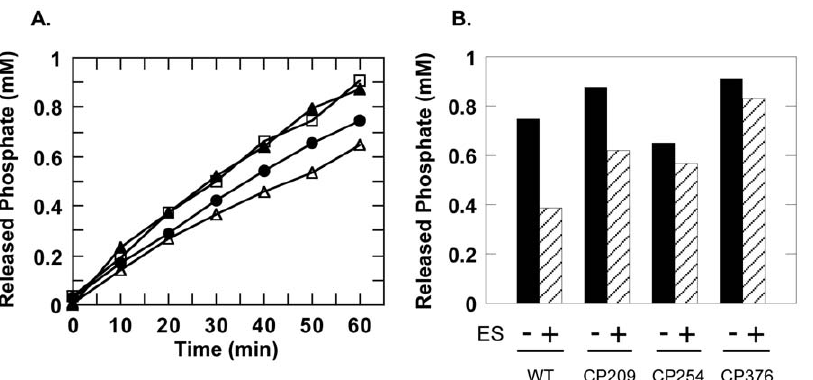
Figure 3. ATPase activities of wild type and CP GroELs. A. Basal ATPase activities measured at 25 u C. Closed circles indicate wild type GroEL, closed triangles indicate CP209. Open triangles indicate CP254 and open squares indicate CP376 ATPase activities. B. ATPase activities in the absence and presence of an equimolar concentration of GroES heptamer. Columns indicate the concentration of inorganic phosphate that was released after a 60 min incubation at 25 u C. Addition of GroES is indicated below each column pair ( hatched columns ). Labels below each column denote the chaperonin measured.